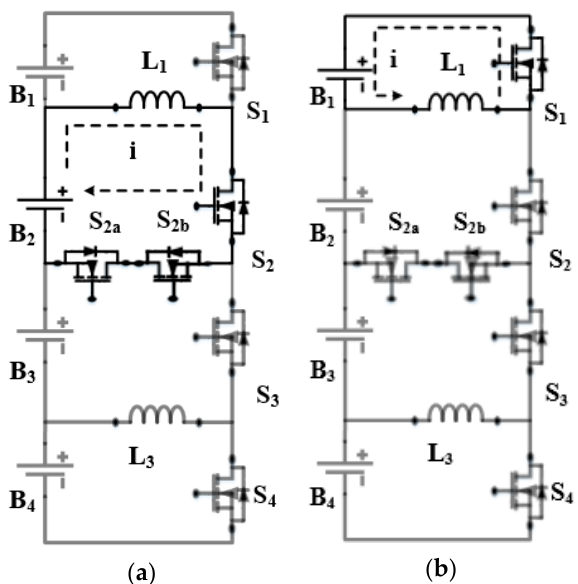
Figure 4. The equalization principle of the NIBNDE. ( a ) Charge L 1 . ( b ) Discharge L 1